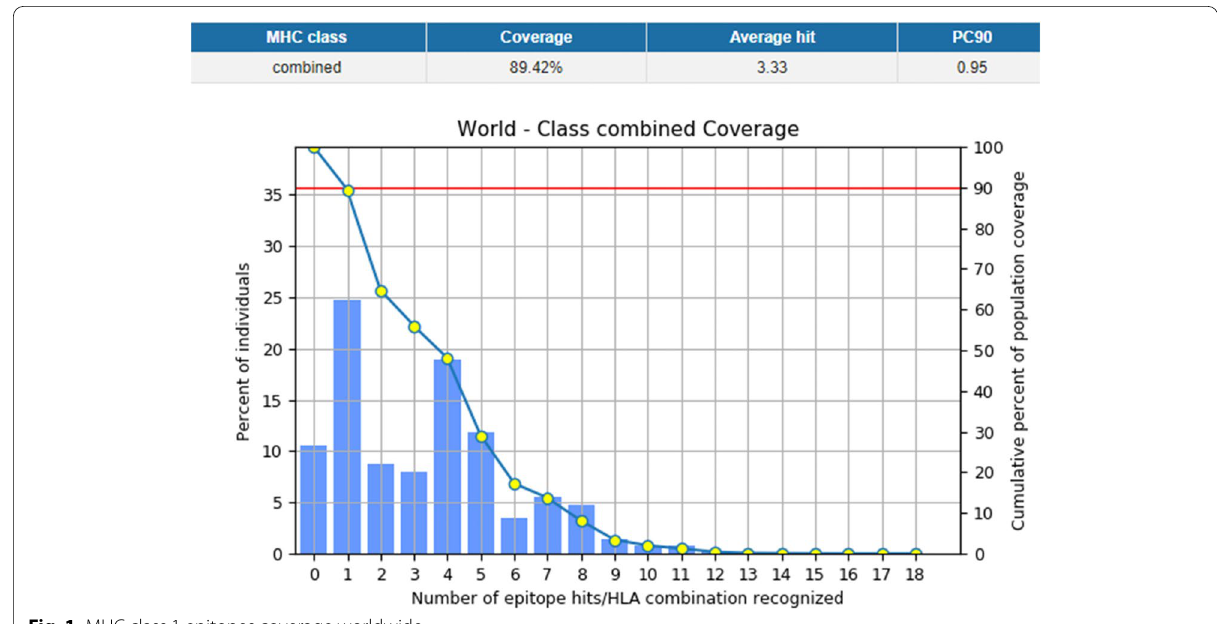
Fig. 1 MHC class 1 epitopes coverage worldwide